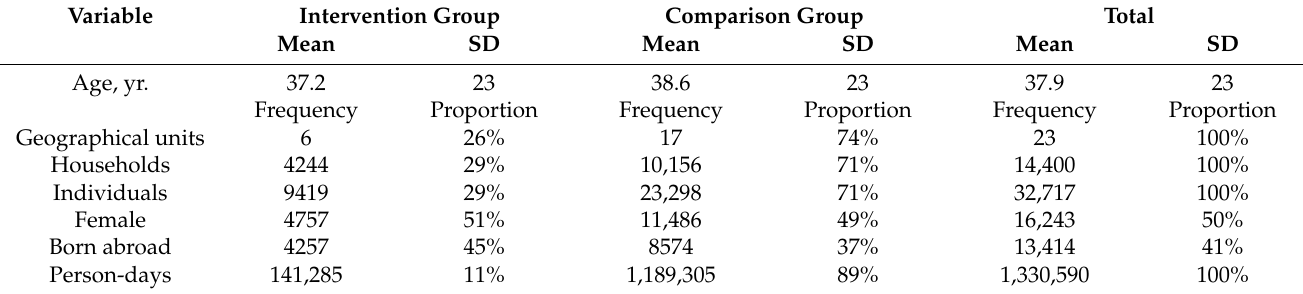
Table 1. Description of the complete sample stratified in the intervention and comparison groups.